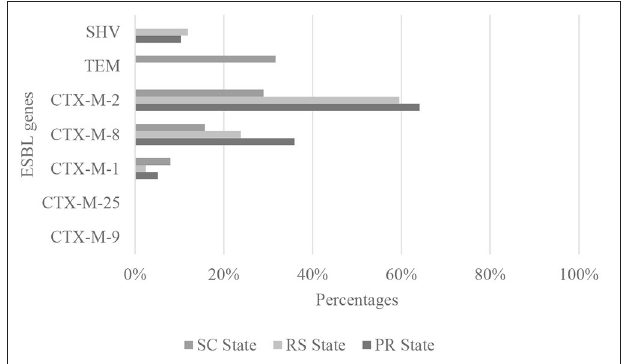
FIGURE 2 | Distribution of ESBL genes encoding CTX-Ms, TEM, and SHV detected in E. coli strains isolated from commercial chicken carcasses in southern Brazil from 2013 to 2014.